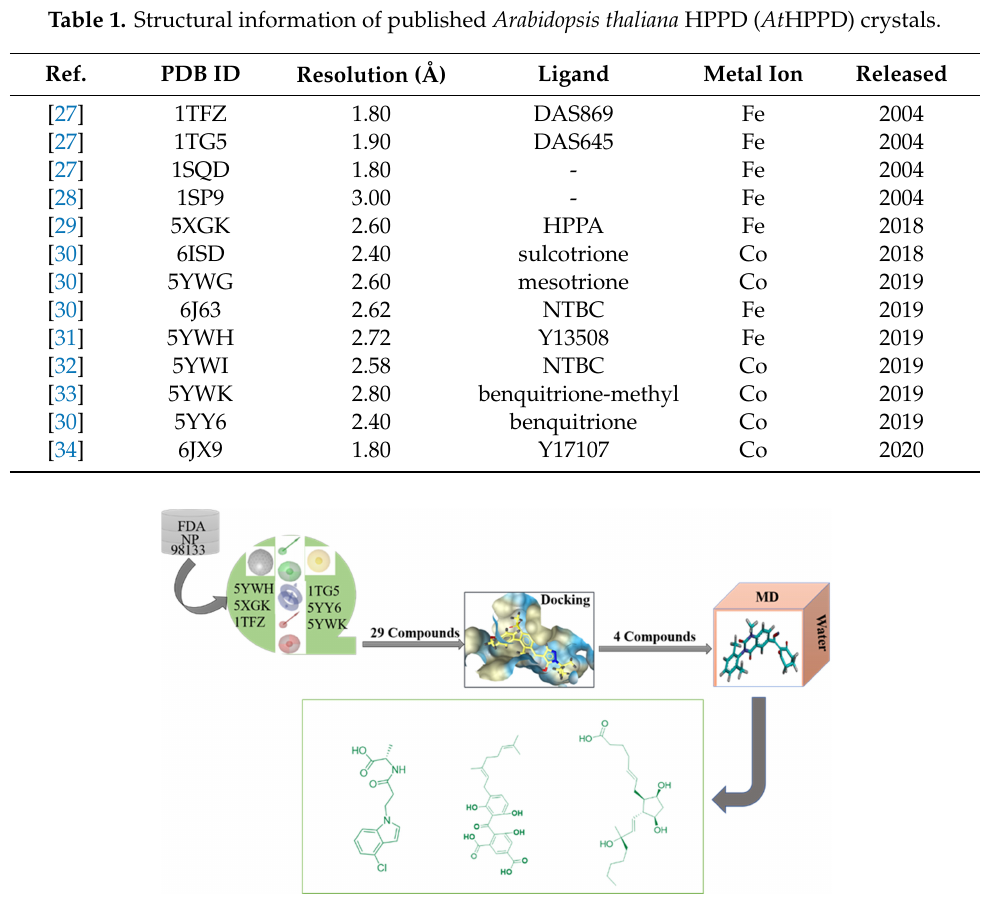
Figure 1. Study design comprising pharmacophore model development, virtual screening, docking and molecular dynamics simulation. Table 1. Structural information of published Arabidopsis thaliana HPPD ( At HPPD) crystals. Ref.